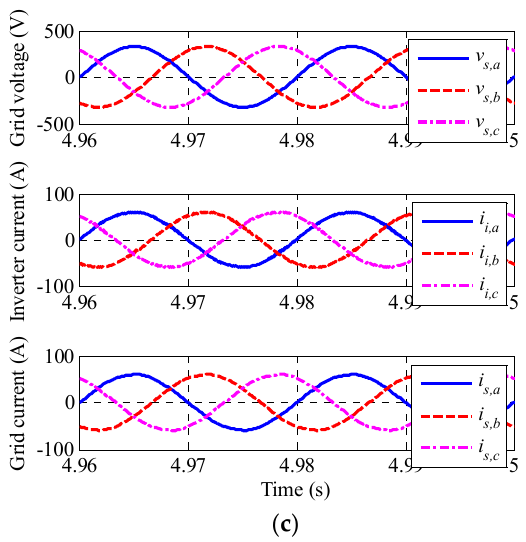
Figure 9. Simulation results. ( a ) Irradiance, PV output voltage; PV output current, PV output power and DC link voltage, ( b ) Voltage and current in the dq frame and power injected into the grid and ( c ) Grid voltage, inverter currents and grid currents.